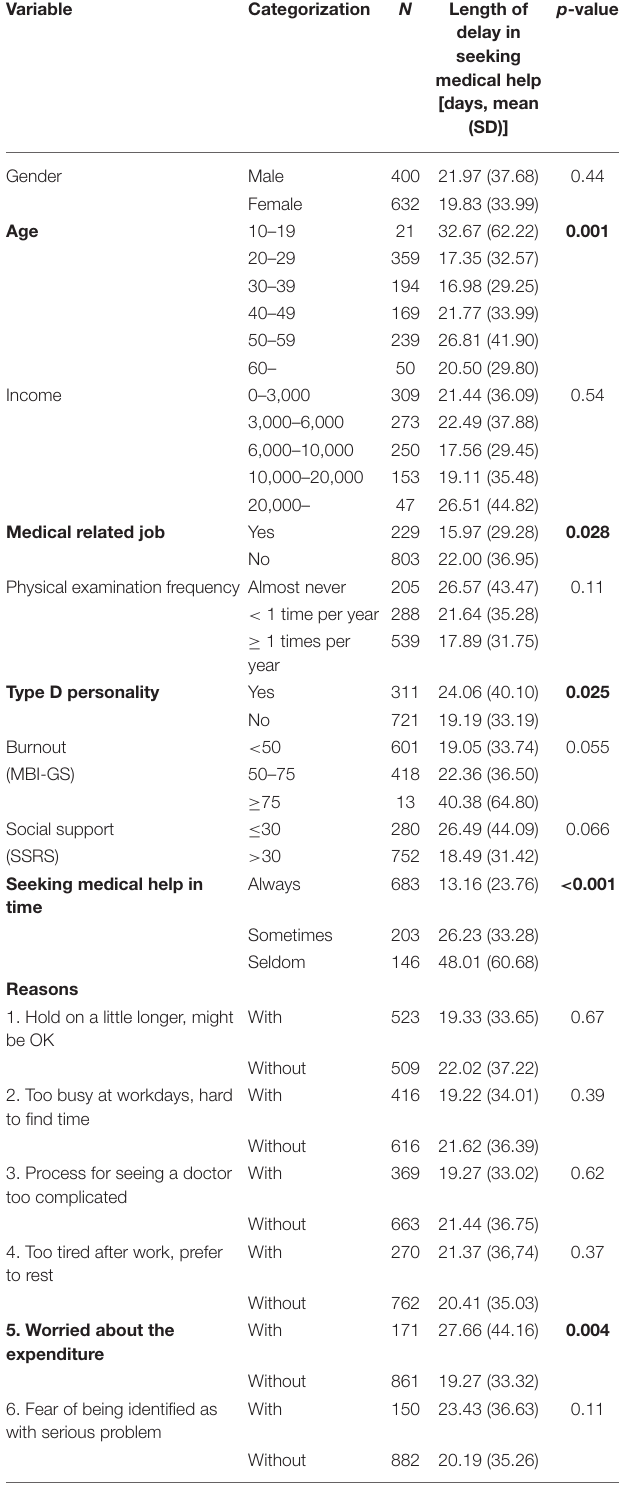
TABLE 1 | Summary of the associations between demographic, psychological characteristics, and prehospital decision time ( n = 1,032). Variable Categorization N Length of